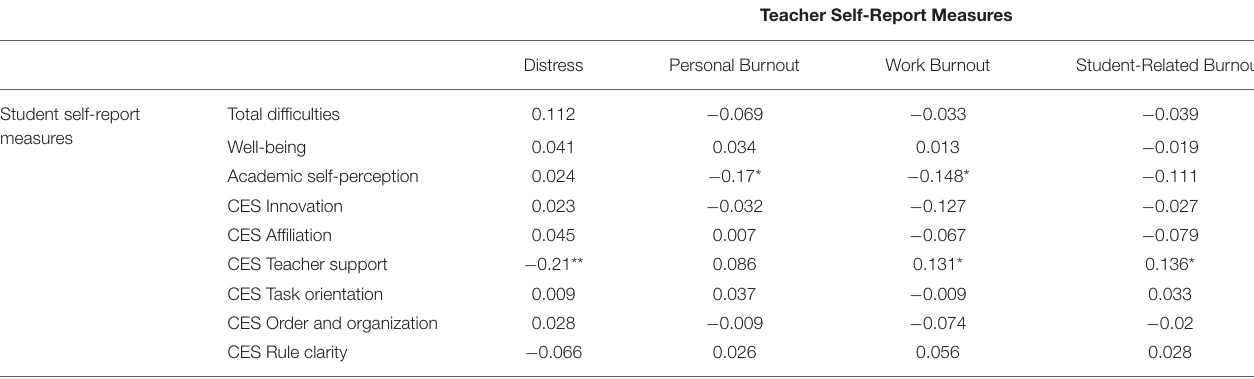
TABLE 3 | Correlations between pre-post-differences for teacher self-report and student self-report Measures.